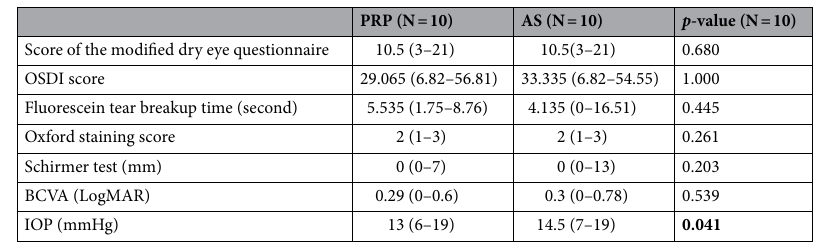
PRP (N = 10) AS (N = 10) p- value (N = 10) Score of the modified dry eye